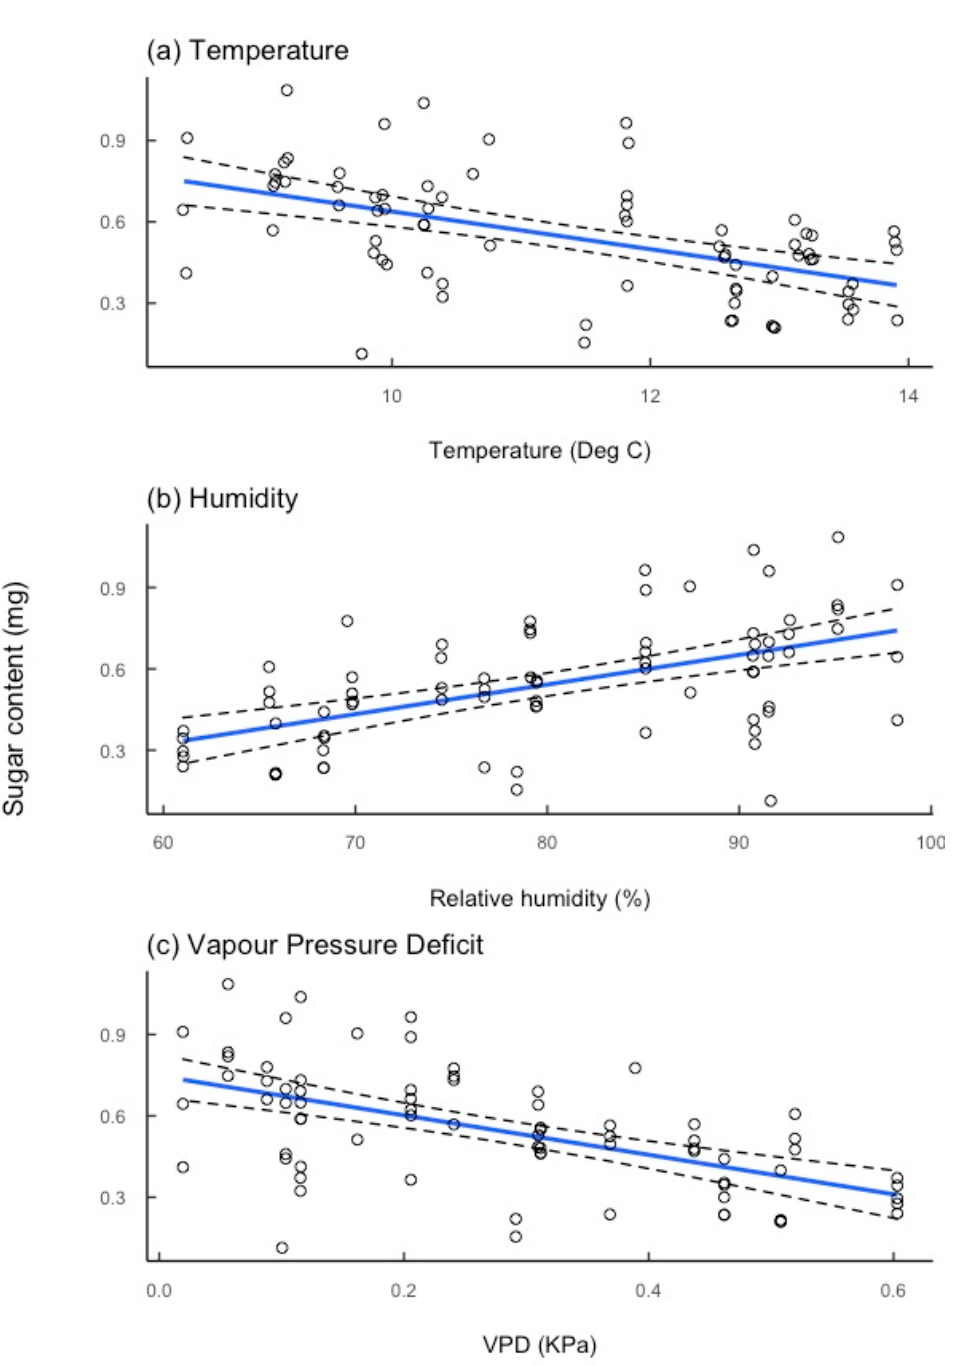
Figure 1. The effect of ( a ) temperature ( F 1,74 = 28.56, p <0.001, R 2 = 0.27, n = 76), ( b ) relative humidity ( F 1,74 = 32.73, p <0.001, R 2 = 0.29, n = 76), and ( c ) vapour pressure deficit ( F 1,74 = 35.78, p <0.001, R 2 = 0.32, n = 76) on sugar per flower (mg) of oilseed rape. Dotted lines show 95% confidence intervals of the mean.